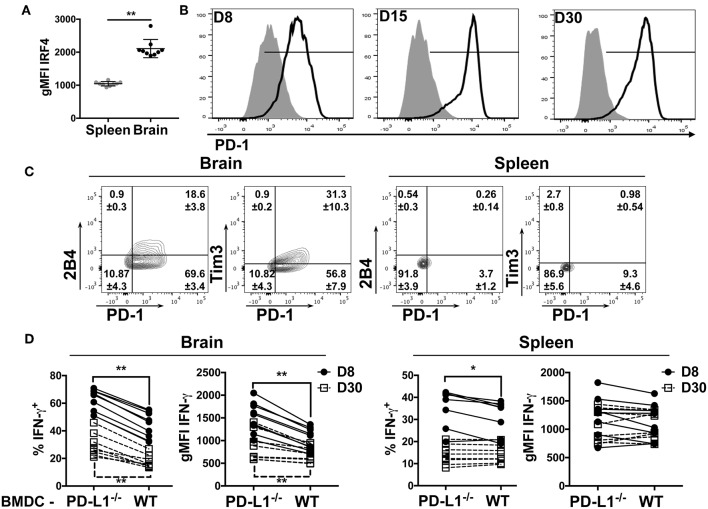
bTRM express PD-1 during MuPyV infection. (A) Expression of IRF4 by DbLT359-specific CD8 T cells from brains and spleens of WT mice at 45 dpi in the indicated groups, represented as gMFI of the population. (B) Representative histograms of PD-1 expression by DbLT359+ CD8 T cells from brain (solid-line) or spleen (shaded) at the indicated dpi. (C) Representative contour plots with frequencies of Tim3/PD-1 and 2B4/PD-1 expressing brain-infiltrating virus-specific CD8 T cells at 45 dpi. (D) Frequency and gMFI of IFN-γ+ CD44+ CD8 T cells from the brain and spleen at the indicated timepoints upon in vitro stimulation with the LT359 peptide-pulsed BMDC from WT and PD-L1−/− mice. Each point connected by a line indicates cells from one mouse. Data are from two independent experiments with 4-5 mice per group. Mann Whitney tests (A) between WT and PD-L1−/− groups and Wilcoxon matched-pairs signed rank test (D) were performed. Values represent mean ± SD; *p ≤ 0.05, **p ≤ 0.01, not significant (ns) p > 0.05.